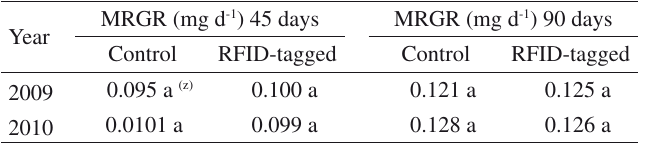
(z) Within each parameter, values in the same line followed by the same